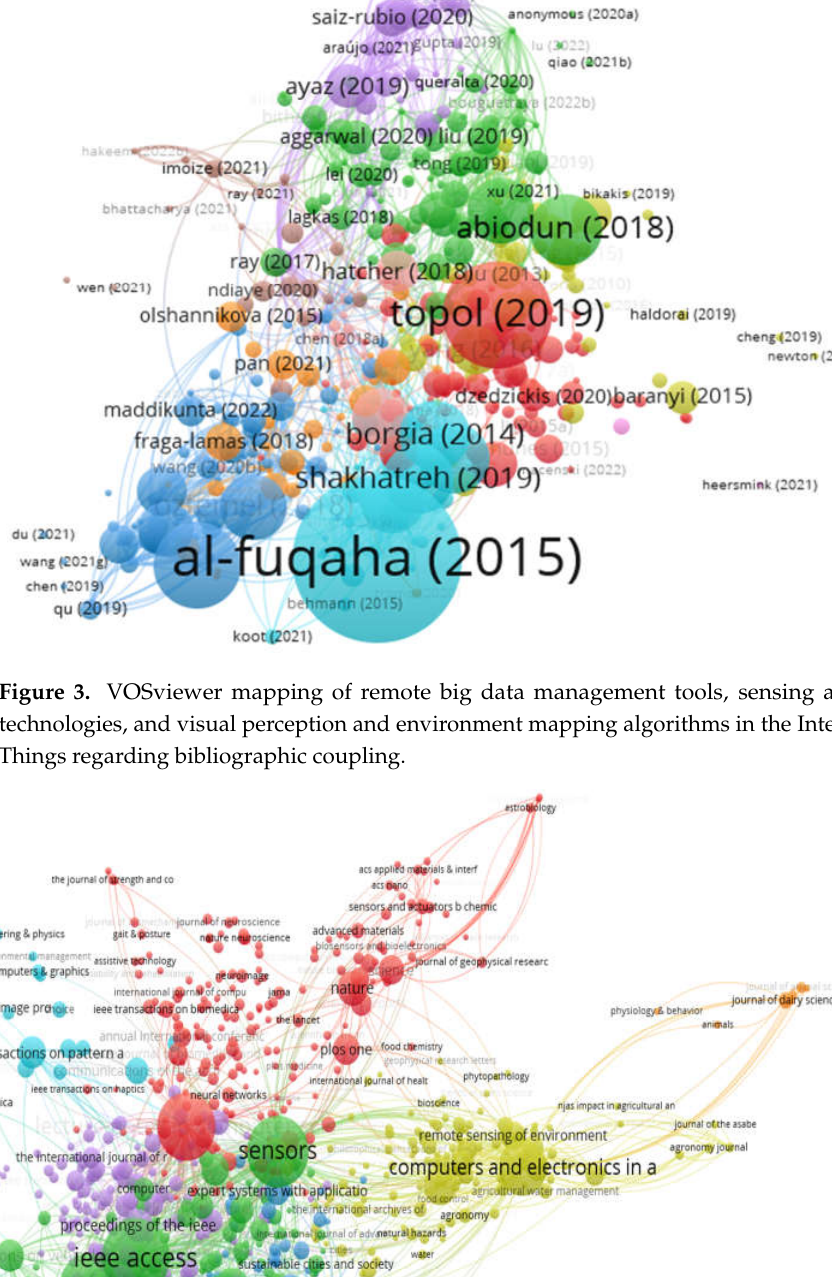
Figure 2. VOSviewer mapping of remote big data management tools, sensing and computing tech- nologies, and visual perception and environment mapping algorithms in the Internet of Robotic Things regarding citation.